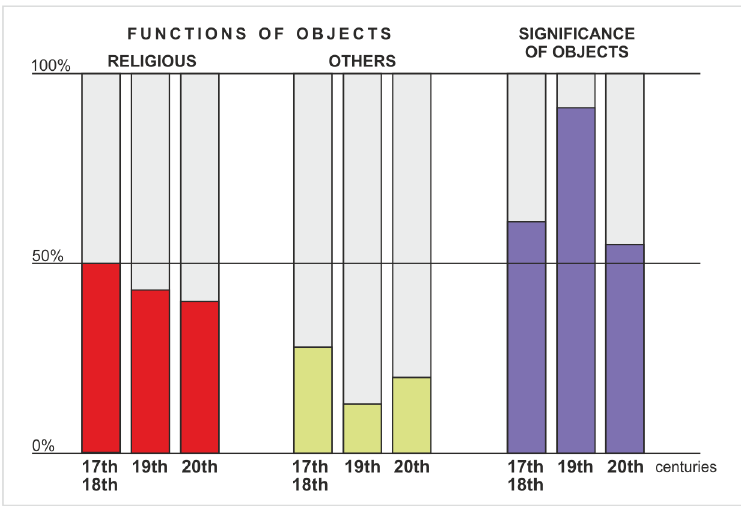
Fig. 2. Percentage of the city maps of Warsaw presenting functions and significance of objects in the total number of city maps in three